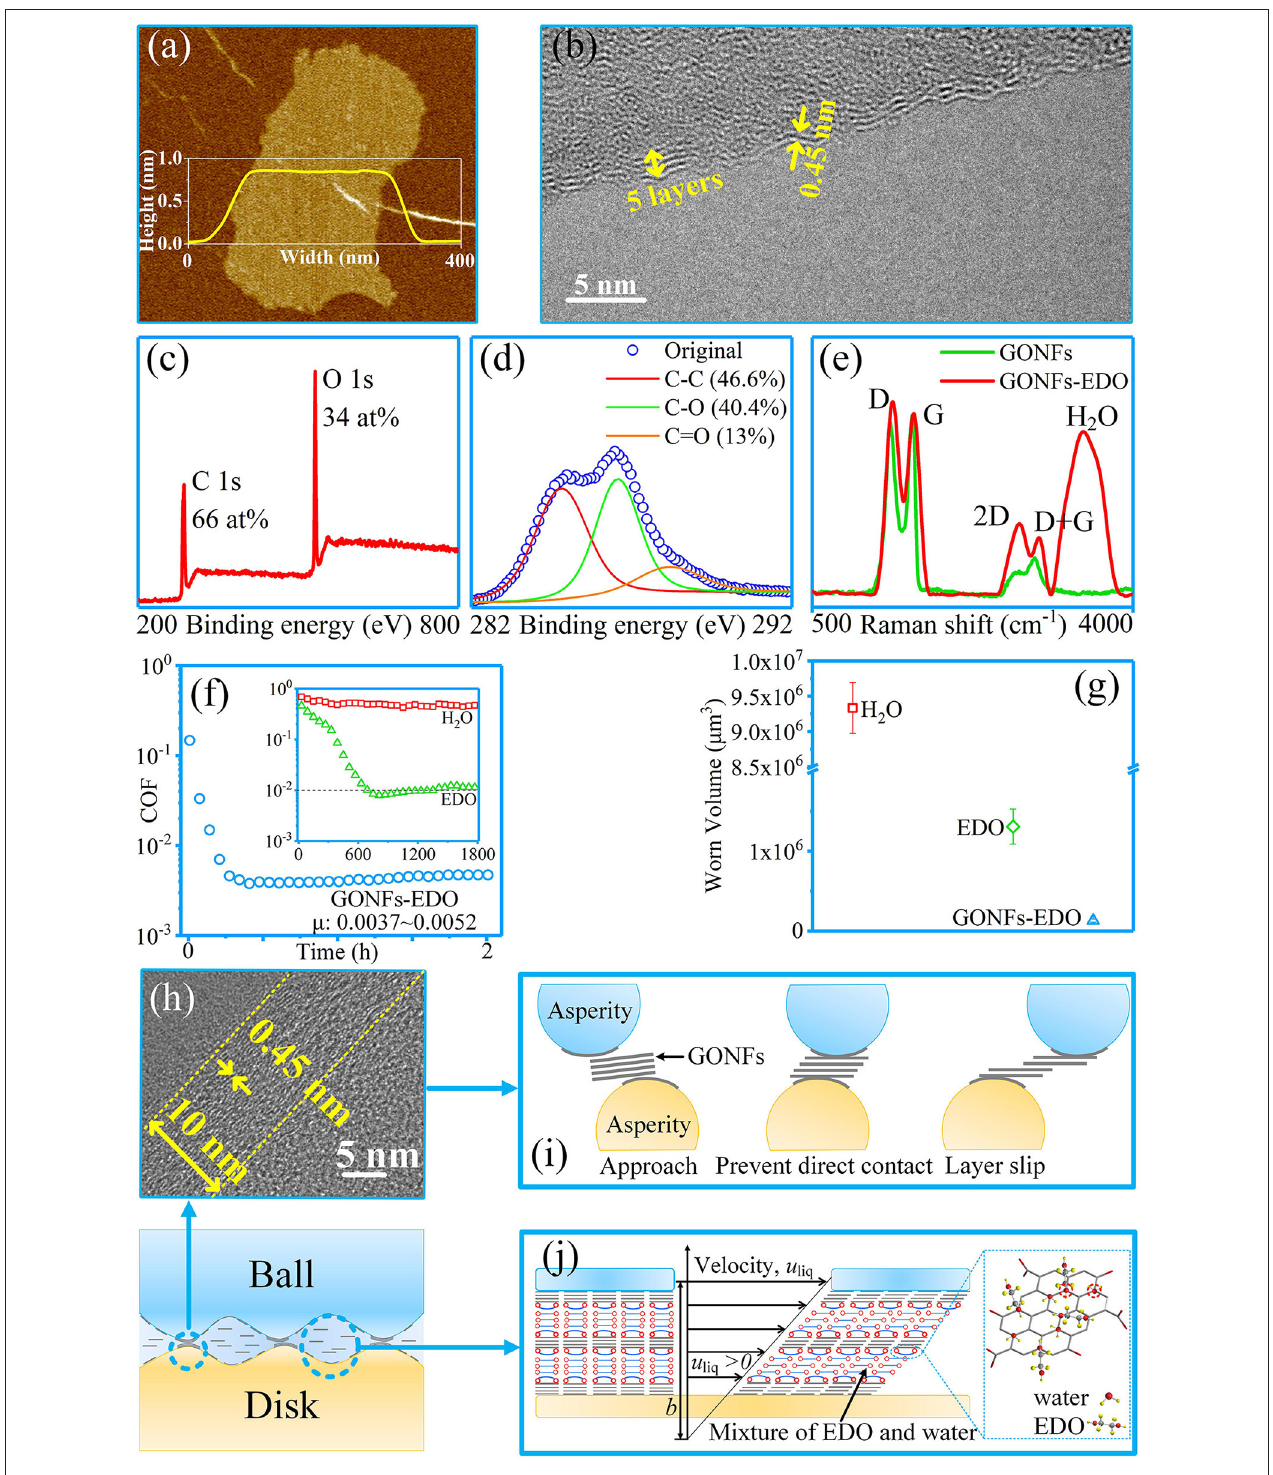
FIGURE 13 | Characterization of GONFs: (a) atomic force microscopy image; (b) high-resolution transmission electron microscopy (HRTEM) image; (c,d) XPS spectra; (e) Raman spectra. (f,g) Friction and wear testing results for GONFs-EDO. (h) HRTEM image of the cross-sectional area of the worn surface. (i,j) Proposed superlubricity and anti-wear mechanism of GONFs-EDO. Ge et al. (2018d) Copyright 2018, American Chemical Society.